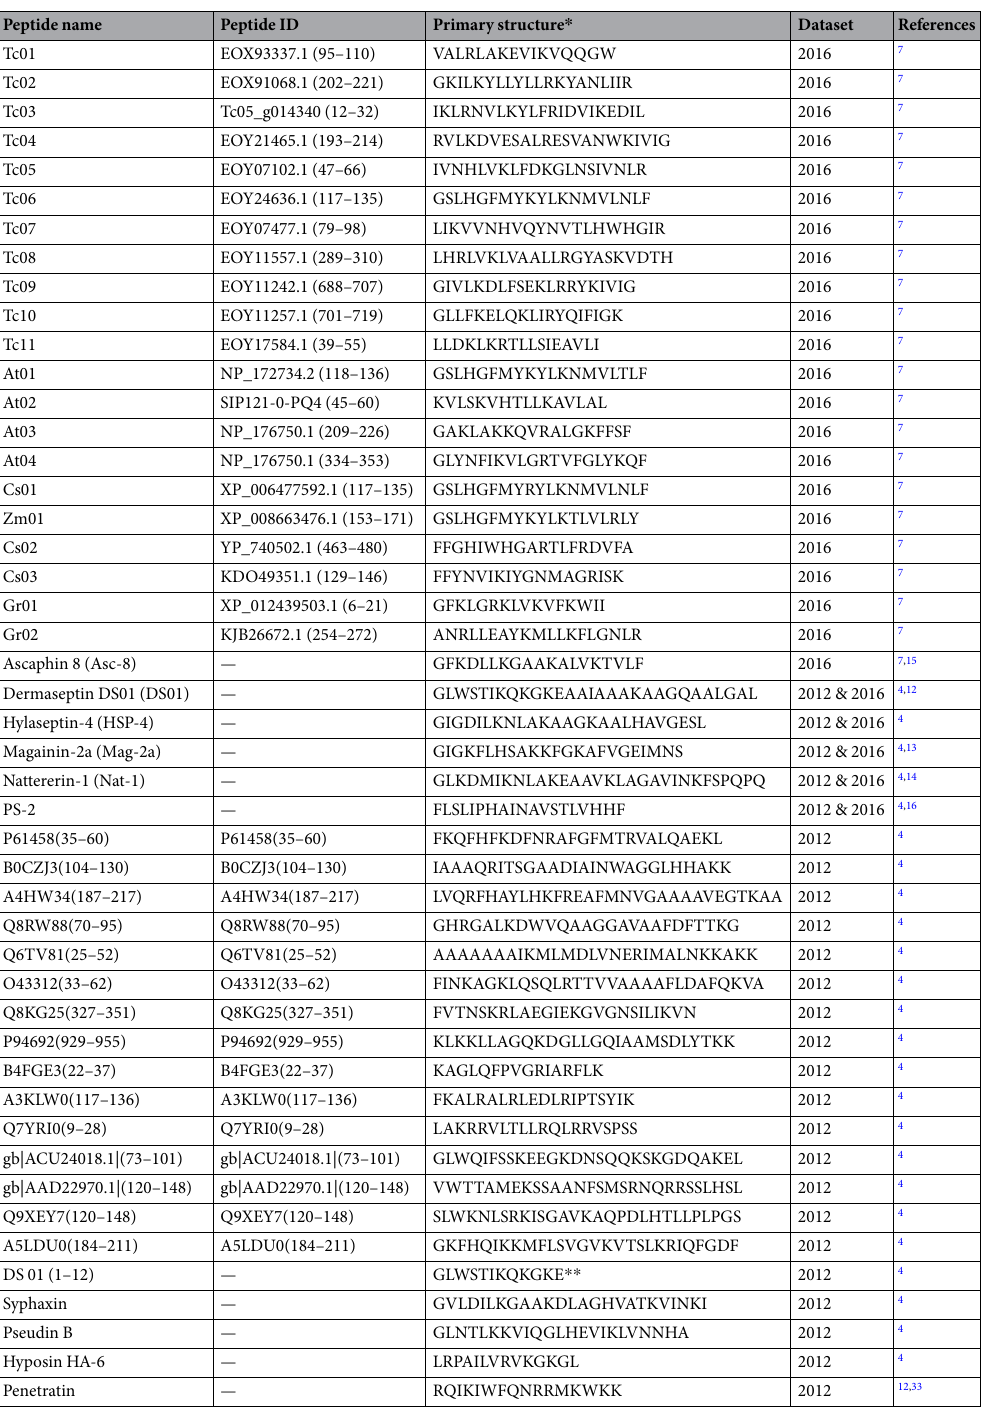
Table 1. Peptide names, ID, primary structures and their corresponding data set. * C-terminally amidated peptides. ** Free